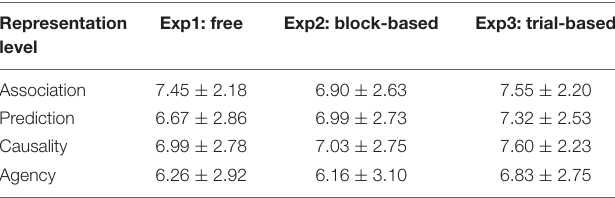
TABLE 1 | Means and Standard deviations of the four different representation levels collapsed over Instructions conditions for all three experiments. Representation